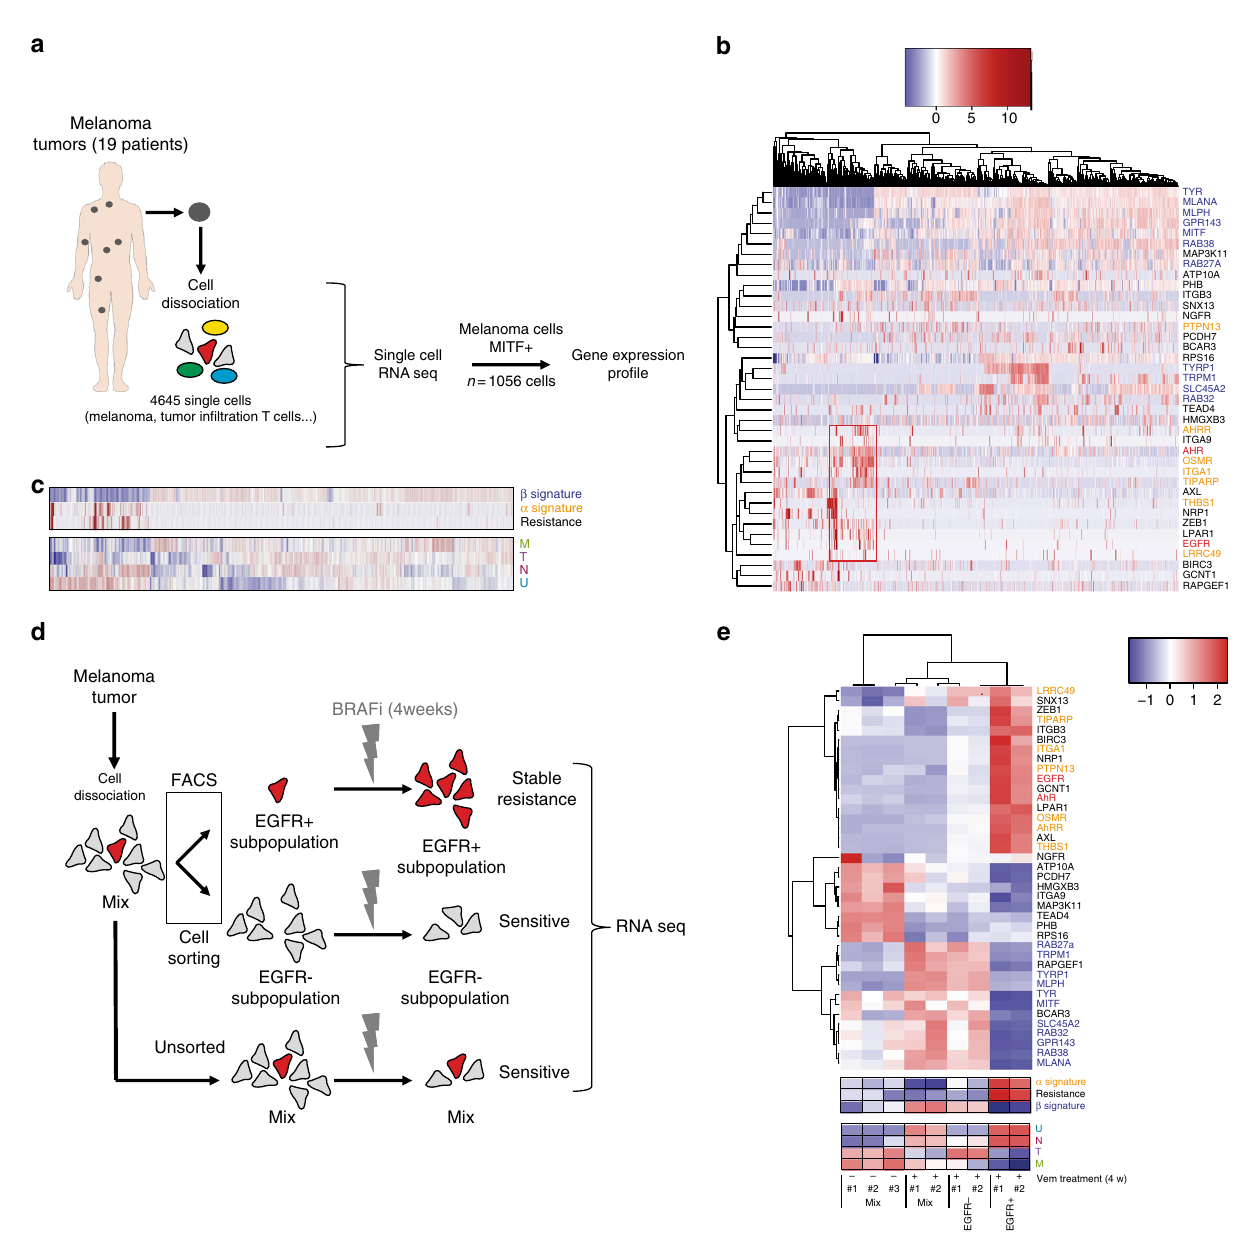
Fig. 4 Role of AhR in melanoma cell resistance: single cell analyses. a Schematic representation of analysis of data from single cell analysis of BRAFi- resistant melanoma (19 patients). Cells from tumors of the different patients have been dissociated and individually sequenced for RNA expression (4650 cells) (RNAseq dataset, GEO, GSE72056 33 ). One fi lter has been included to only focus on melanoma cells expressing the MITF gene. b Expression Heatmap for genes corresponding to α - and β -signatures and depicting mRNA expression of individual genes for BRAFi resistance genes using data from single cell analysis of BRAFi-resistant melanoma (19 patients) (1056 cells). c Expression heatmap for average β -, α -, and resistance signatures (top) and melanoma differentiated state signatures using data from single cell analysis of BRAFi-resistant melanoma. d Schematic representation of analysis of data using an RNA-Seq dataset obtained from BRAFi-treated melanoma cells (from 2 patients) (from supplemented information 16 ). Cell sorting has been performed on dissociated tumors to isolate EGFR-negative or -positive cells that are able to resist BRAFis and to generate colonies after long-term treatment. e Expression heatmap for genes corresponding to individual genes (top) of α - and β -signatures and depicting mRNA expression for BRAFi resistance, average signatures (middle) and differentiated state signatures (bottom) using an RNA-Seq dataset obtained from BRAFi-treated melanoma cells 16 . The human silhouettes have been adapted (change of color background) from Servier Medical Art, licensed under a CC BY 3.0 FR